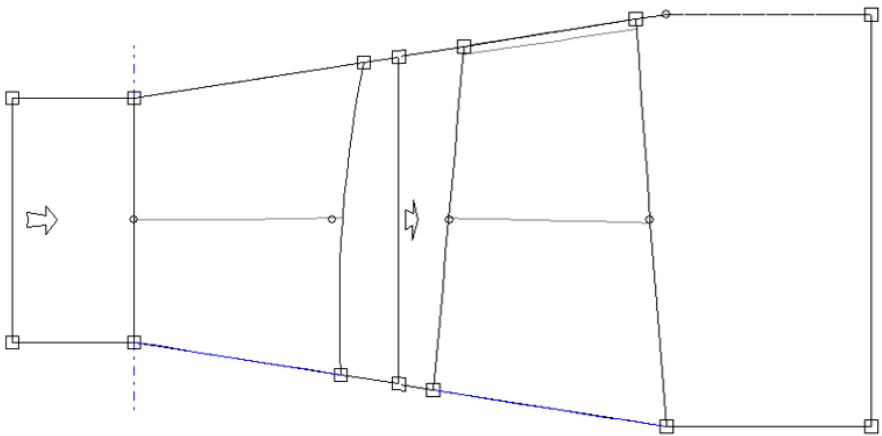
Figure 10. Meridional side view of optimised blades.